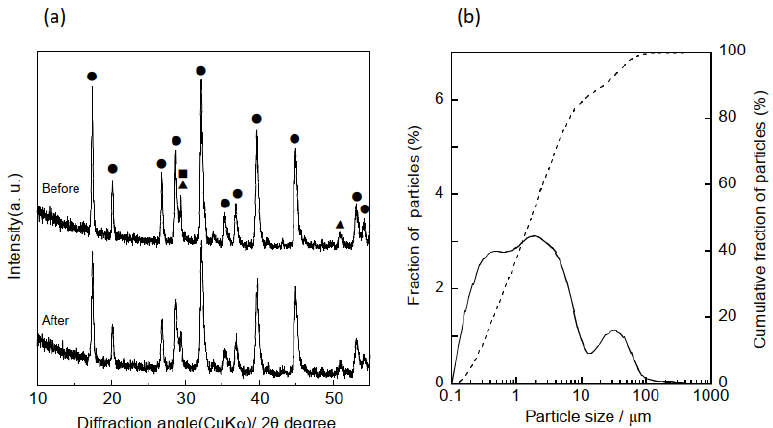
Figure 1. ( a ) XRD patterns of hydrogarnet before and after the ball milling ( • ) hydrogarnet, ( (cid:78) ) C-S-H gel, ( (cid:4) ) calcite, and ( b ) particle size distribution curves of hydrogarnet after the ball milling. Solid and dotted lines indicates the fraction and cumulative fraction of particle size, respectively.